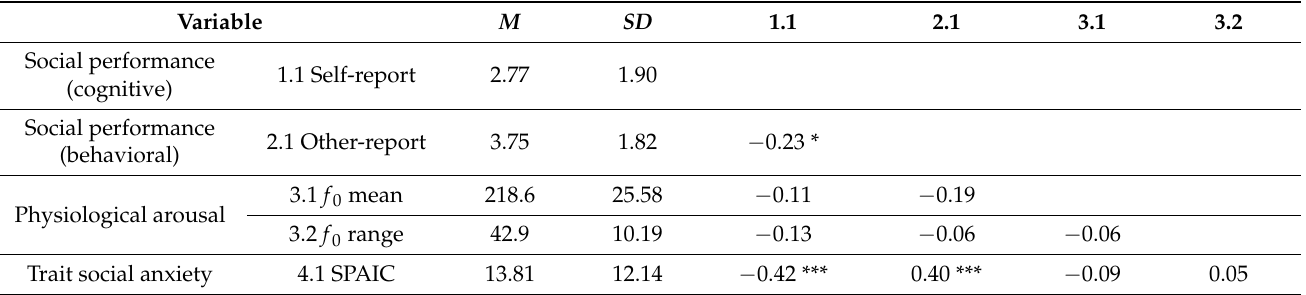
Table 3. Means, Standard Deviations, and Pearson Correlations for Variables Before CBT or Waiting ( n = 118).